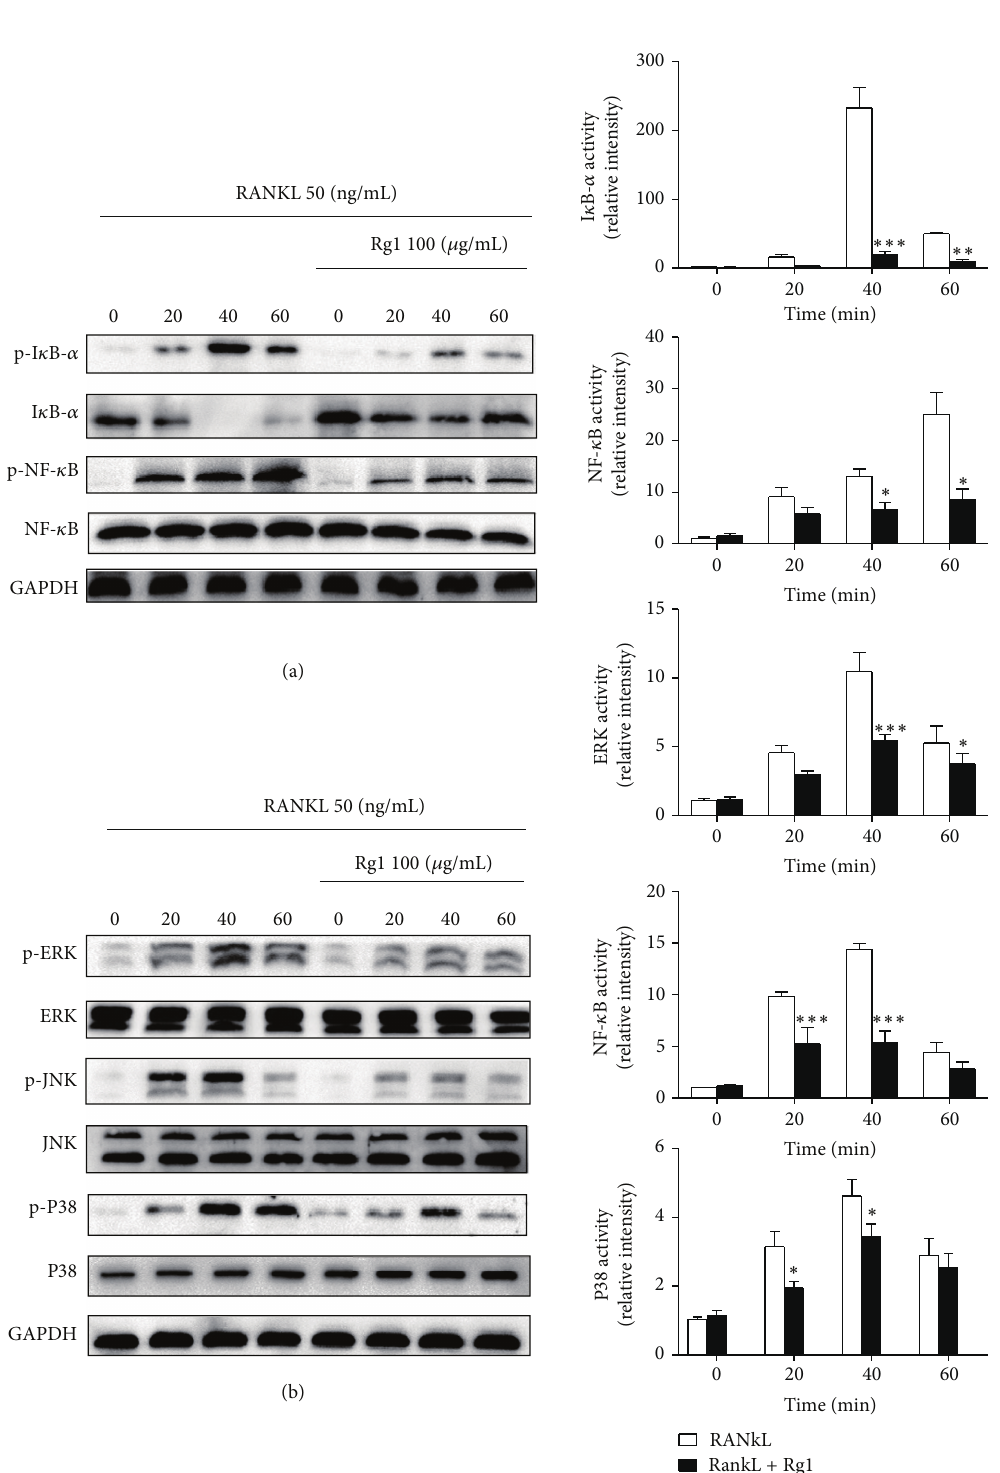
Figure 5: Effects ofRg1 onRANKL-induced I 𝜅 B, NF- 𝜅 B,and MAPkinaseactivation. I 𝜅 B,NF- 𝜅 B, and MAPkinase activation was represented by the levels of protein phosphorylation. RAW 264.7 cells (1 × 10 5 cells/mL) were cultured with or without Rg1 (100 𝜇 g/mL) in the presence of RANKL for indicated times. Western blot analysis was performed with whole cell lysates (10mg). Blots were probed with antibodies specific for I 𝜅 B, NF- 𝜅 B, and MAP kinase. The densities of phosphorylated protein (p-) levels (upper panels) were normalized to the density of total protein levels (lower panels). GAPDH was used as the loading